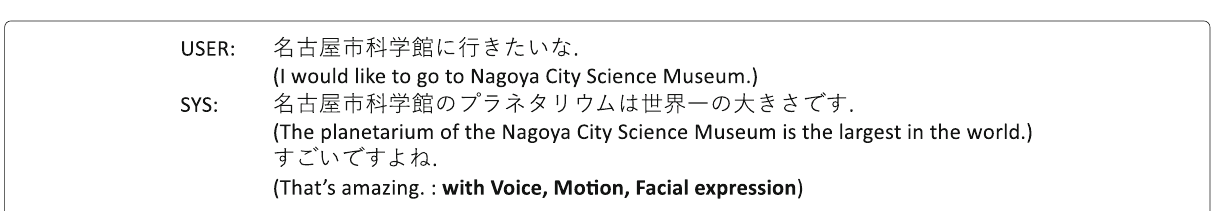
Fig. 5 Example of a dialog provided by a user